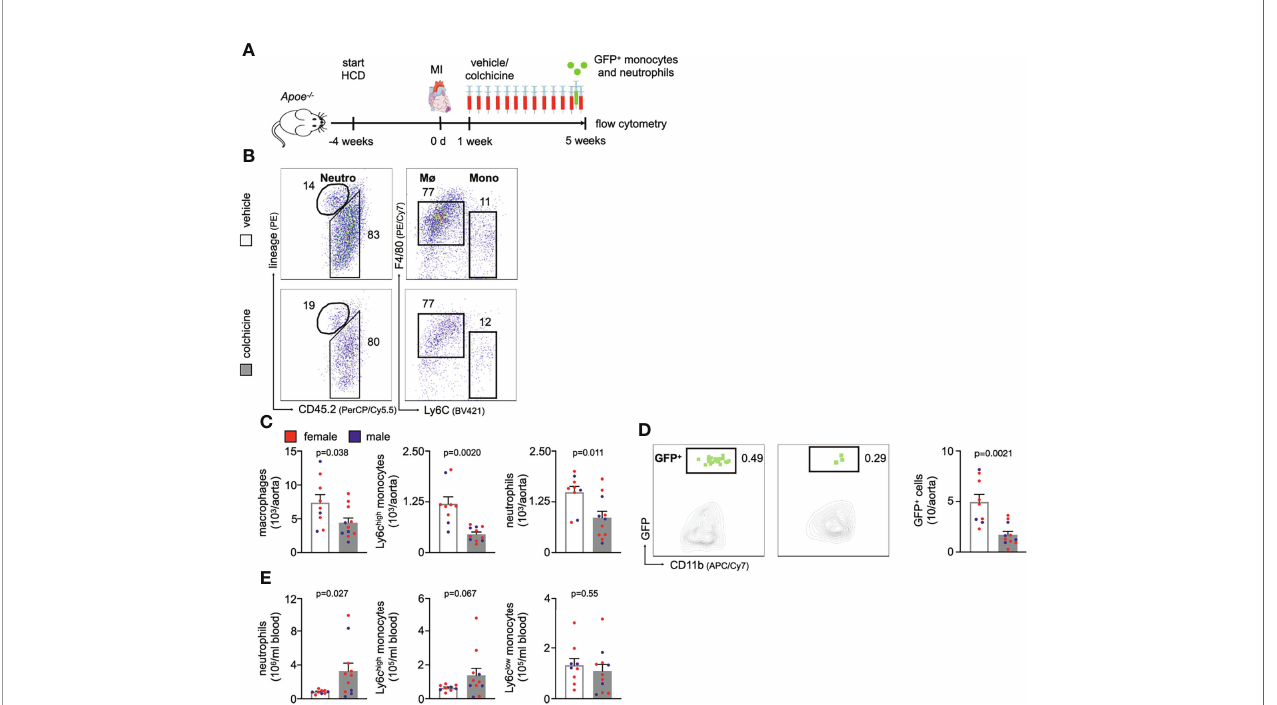
FIGURE 6 | Colchicine treatment reduces vascular in fl ammation in post-myocardial infarction accelerated atherosclerosis. (A) Experimental scheme for Figures 6B-E . In brief, Apoe -/- mice on a high cholesterol diet (HCD) were subjected to myocardial infarction (MI) and treated with either vehicle or colchicine for four weeks starting one week after induction of MI. (B) Flow cytometric gating and (C) quanti fi cation of leukocyte subsets in atherosclerotic aortas in vehicle- vs. colchicine-treated Apoe -/- mice which were infarcted fi ve weeks prior ( n =9-11 per group, 64-67% female, Student ’ s t -test for macrophages and neutrophils, Welch ’ s t -test for monocytes). Neutro: neutrophils, Mø: macrophages and Mono: monocytes (D) Flow cytometric gating and quanti fi cation of GFP high myeloid cells (GFP + ) in atherosclerotic aortas 24h after adoptive transfer of GFP high monocytes and neutrophils into vehicle- vs. colchicine-treated Apoe -/- mice which were infarcted fi ve weeks prior ( n =9-11 per group, 64-67% female, Welch ’ s t - test). (E) Quanti fi cation of blood leukocyte subsets in vehicle- vs. colchicine-treated Apoe -/- mice which were infarcted fi ve weeks prior ( n =9-11 per group, 64-67% female, Welch ’ s t -test for neutrophils, Mann-Whitney U -test for Ly6C high monocytes, Student ’ s t -test for Ly6C low monocytes). Data are presented as mean+s.e.m. Numbers next to gates indicate population frequencies (%). Dots within bar plots show the gender of the mice with a color code: purple (male) and red